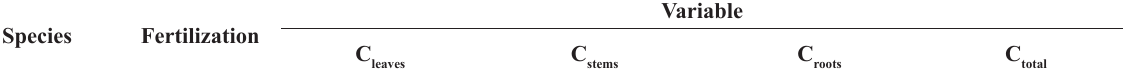
Carbon sequestration rates of the different plant components, leaves, stems and roots, of three Amazonian leguminous trees under different fertilization treatments in a forest restoration plantation in an area degraded by the Balbina Hydroelectric Dam, AM, Brazil. T1 – no fertilization, T2 – chemical fertilization, T3 – organic fertilization, and T4 – organic and chemical